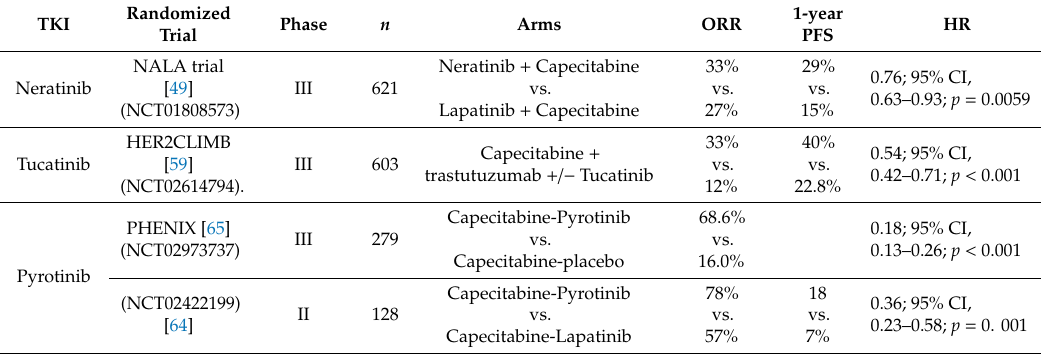
Table 4. Results of randomized phase II and III trial assessing the e ffi cacy of novels TKI in HER2-positive